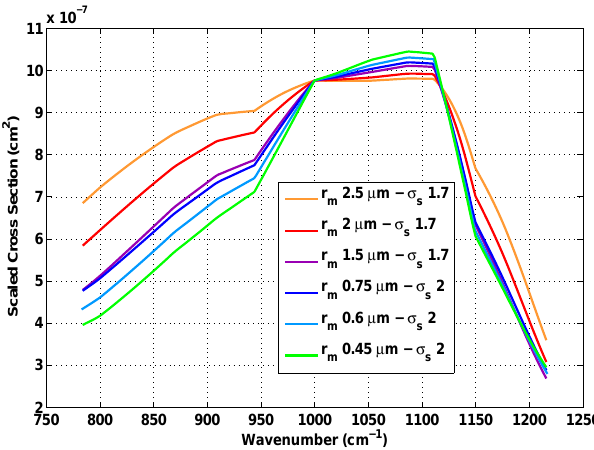
Fig. 3. Forward modelling of the radiance that would be observed by IASI for two particle size distributions associated with an aerosol layer at two different altitudes (optical depth of 1 at 10µm). The corresponding forward modelling in absence of aerosols is also rep-